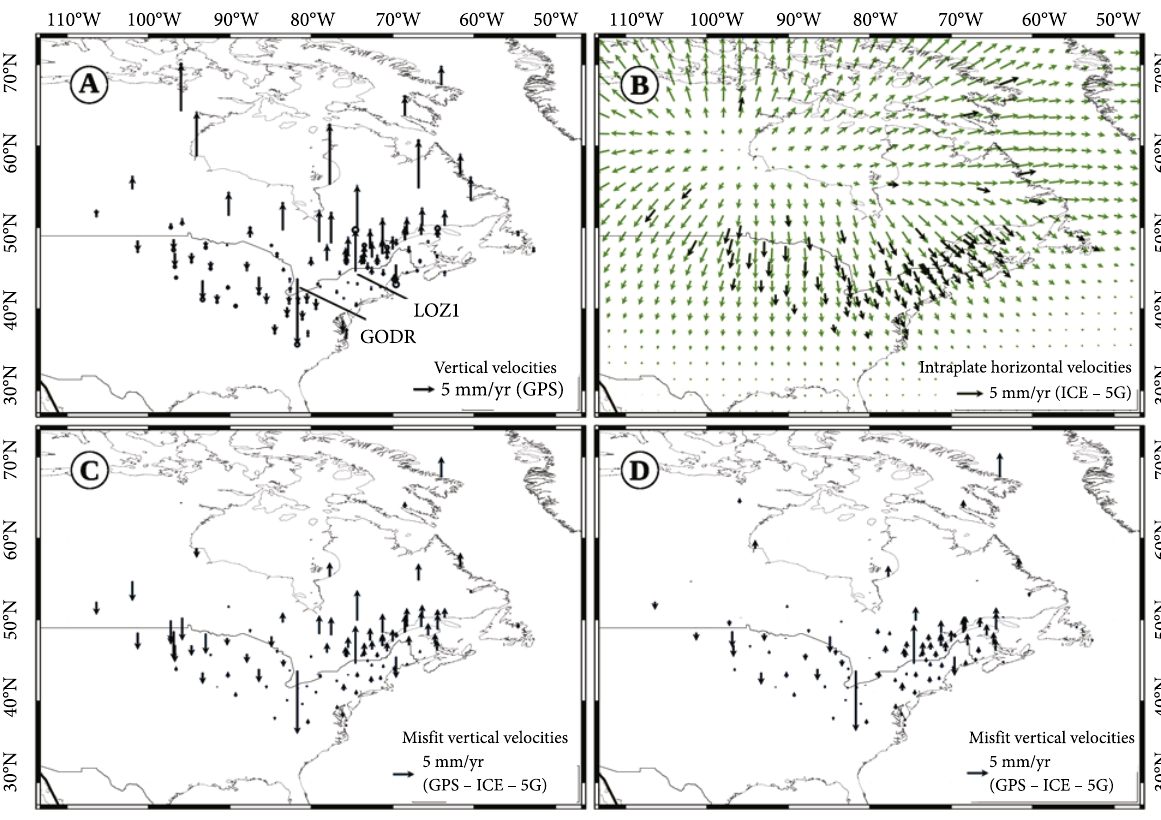
Fig. 6. (A) Overview of the vertical velocity field obtained from CGPS observations. Stations GODR and LOZ1 have very different vertical velocities with larger sigma values compared to the nearby stations and therefore are excluded. (B) Horizontal velocity field predicted by the ICE-5G model. Bold arrows show predicted velocities by this model at the CGPS stations. (C–D) Misfits between CGPS-derived vertical velocities and predicted velocities from ICE-5G and ICE-6G models, respectively. Misfits in (C) are larger than in (D) and are spatially